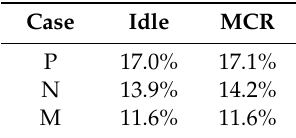
Table 3. Pilot air-flow rate relative to burner air-flow rate in the combustion tests. (Copyright by ASME—“E ff ects of Fluidic Control of Air-Flow Distribution on Staged Lean Jet Engine Burner,” by Yoshida, Schneider, Hassa, Paper No: GT2016-57453).